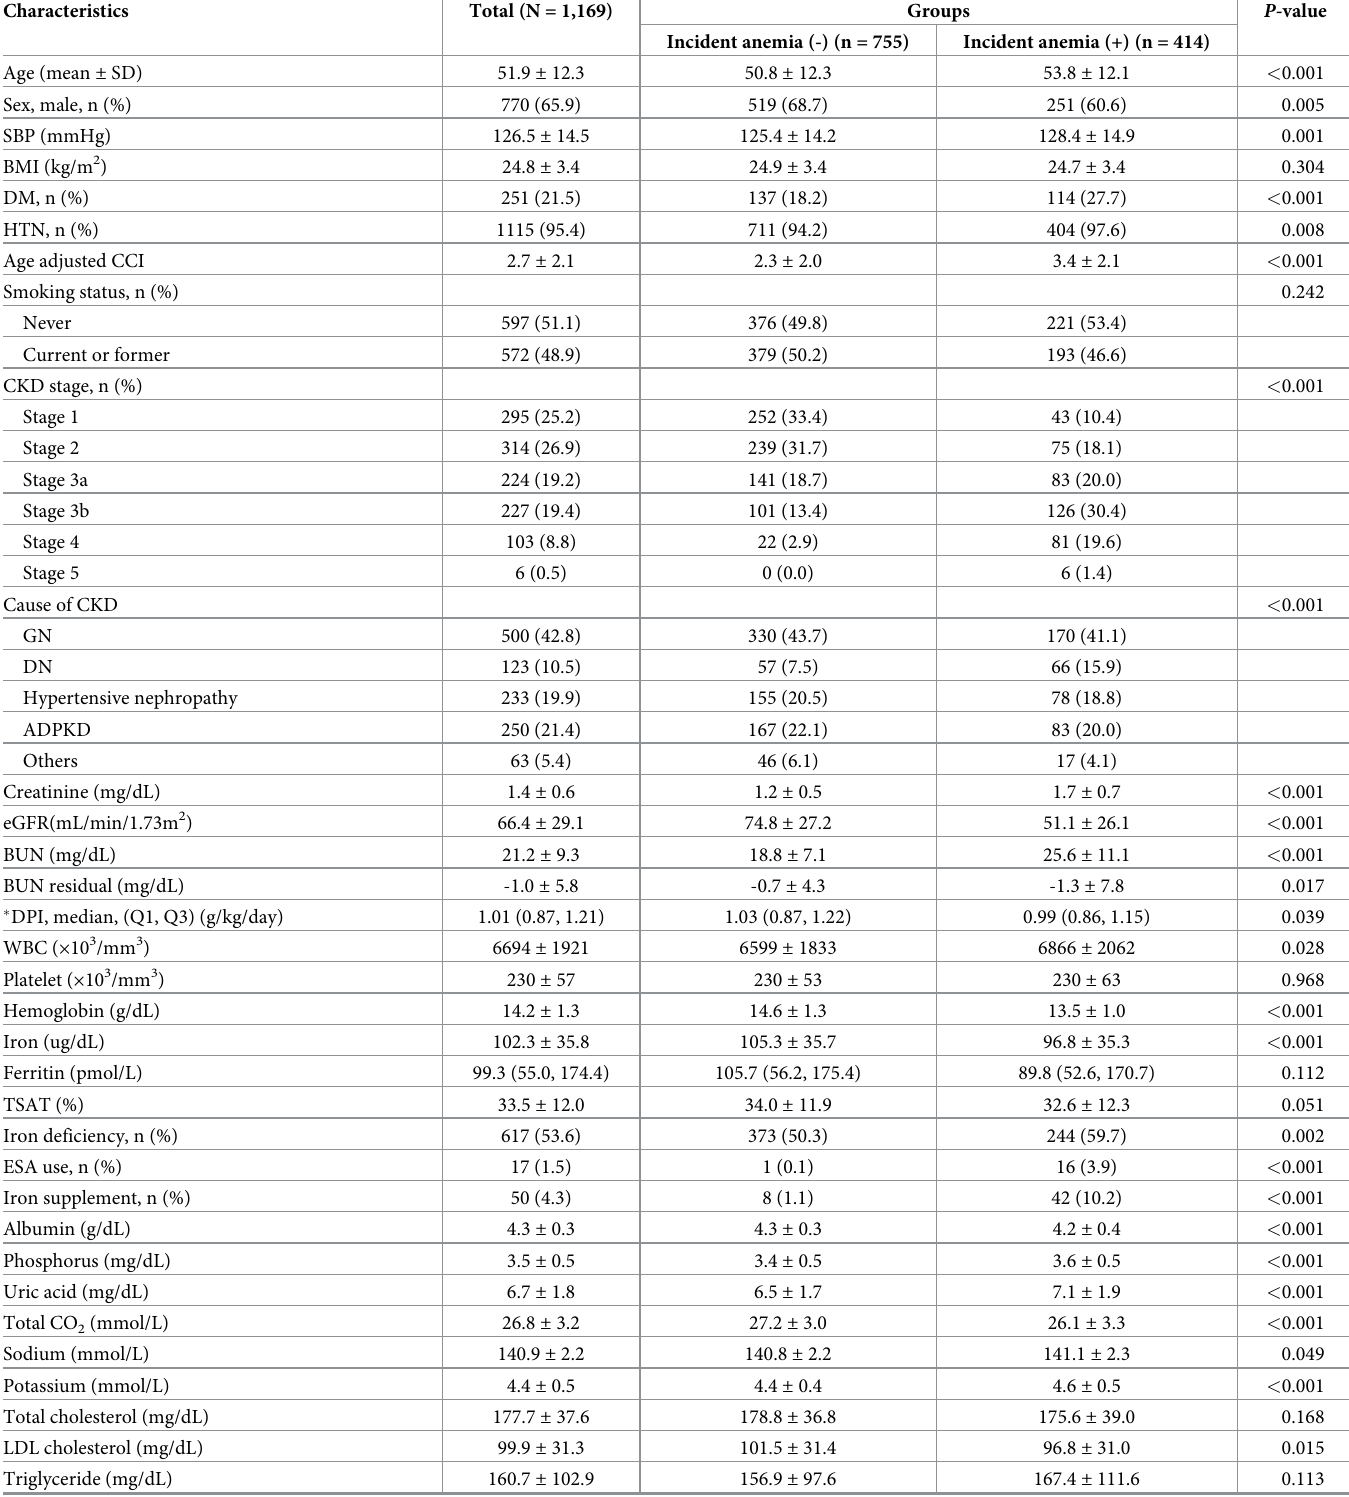
Table 3. Clinical characteristics of the study subjects with respect to anemia development.